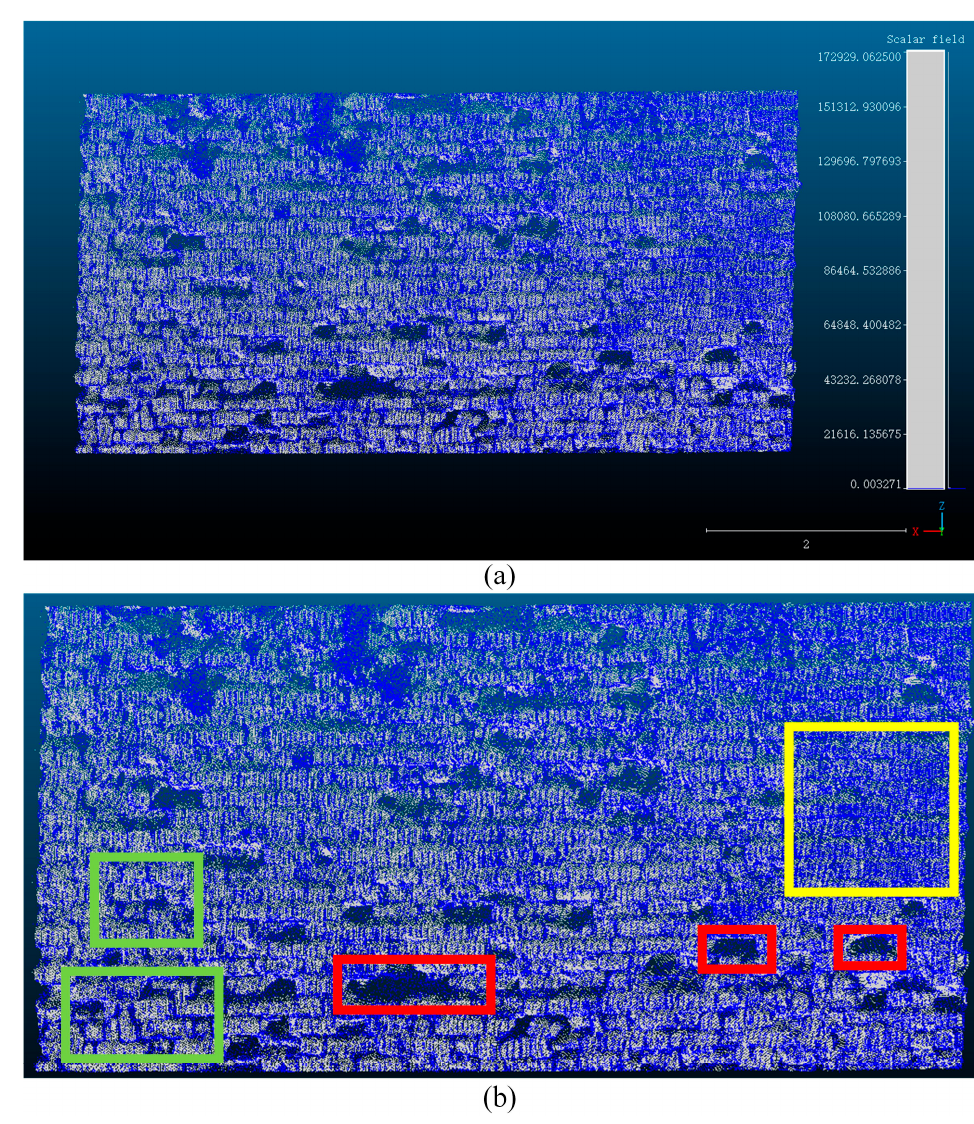
Figure 28. ( a ) Visualization of Structural Tensor Linearity. ( b ) Defect analysis diagram. (The red boxes indicate the detachment of bricks; the green boxes indicate cracks in the wall, and the yellow box indicates the normal bricks without defects).